Question: Which kind of chart has been used to present this data?
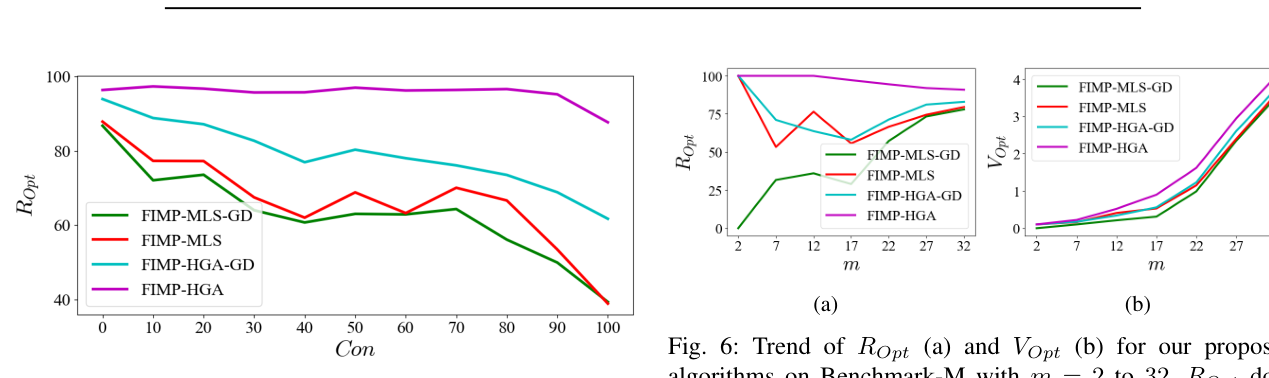
Answer: line